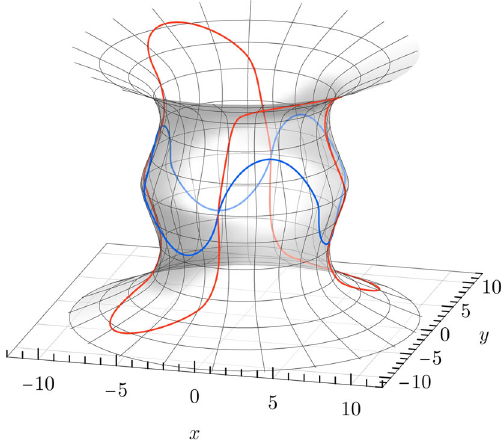
Fig. 38 3D view of the orbit of Fig.